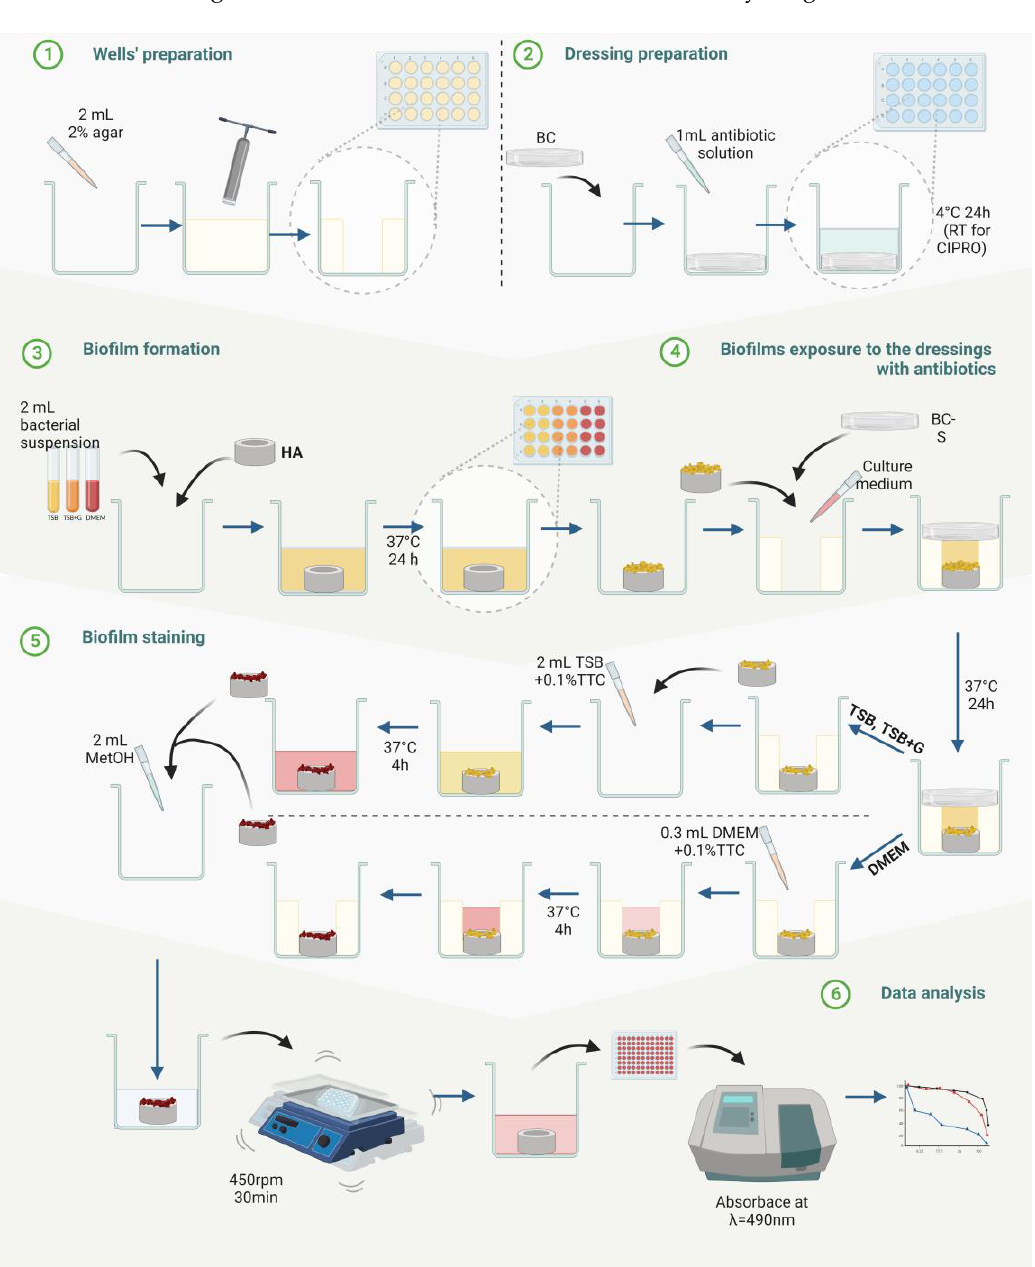
Figure 7. Schematic diagram of modified antibiofilm dressing’s activity measurement (A.D.A.M.). BC—bacterial cellulose, BC-S—bacterial cellulose saturated with antibiotic, HA—hydroxyapatite disk, TSB—tryptic soy broth, TSB + G—tryptic soy broth with 1% glucose, DMEM—Dulbecco’s Modified Eagle’s Medium, TTC— tetrazolium chloride solution, and MetOH — methanol.